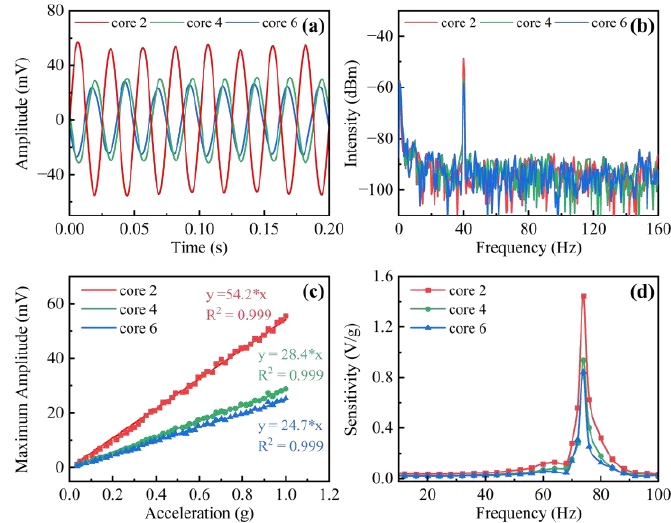
Figure 4. ( a ) Real-time reflected power and ( b ) the corresponding FFT spectrum in cores 2, 4, and 6 with an exciting frequency of 40 Hz and an acceleration of 1.0 g. ( c ) Reflected power versus applied acceleration ranging from 0.03 to 1.0 g; ( d ) sensitivity-frequency responses of the FBGs in cores 2, 4, and 6 with an acceleration of 1.0 g under an orientation angle of 350°.